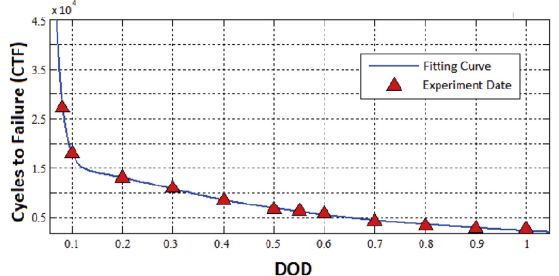
Figure 3. Cycle life curve of a Li-ion Battery.